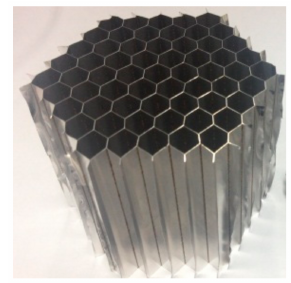
Figure 7. Aluminum honeycomb.